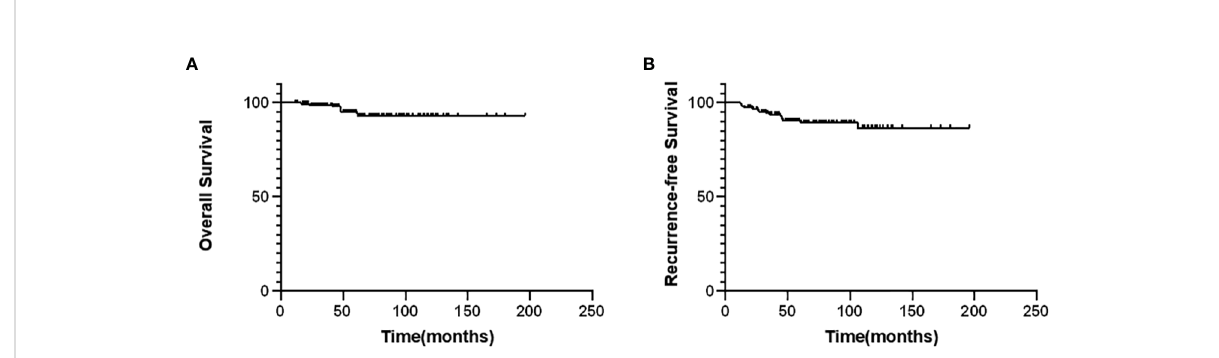
FIGURE 2 Kaplan – Meier curves for the overall survival (A) and recurrence-free survival (B)